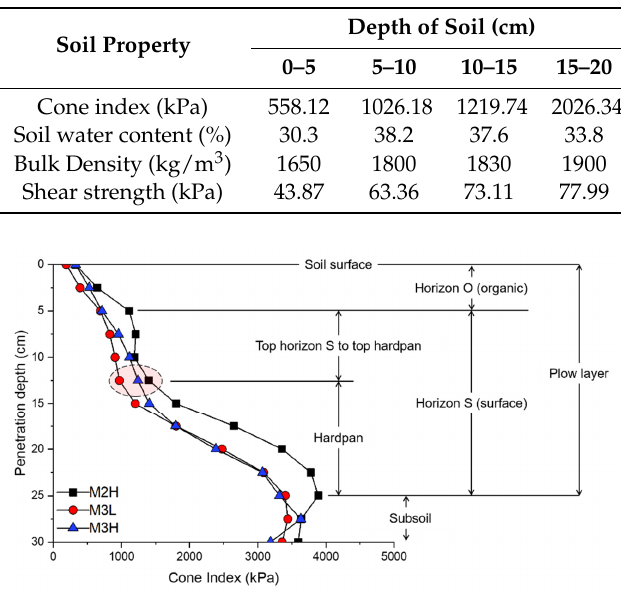
Figure 5. Analyzed soil profile and hardpan depth based on the cone index measurement results.